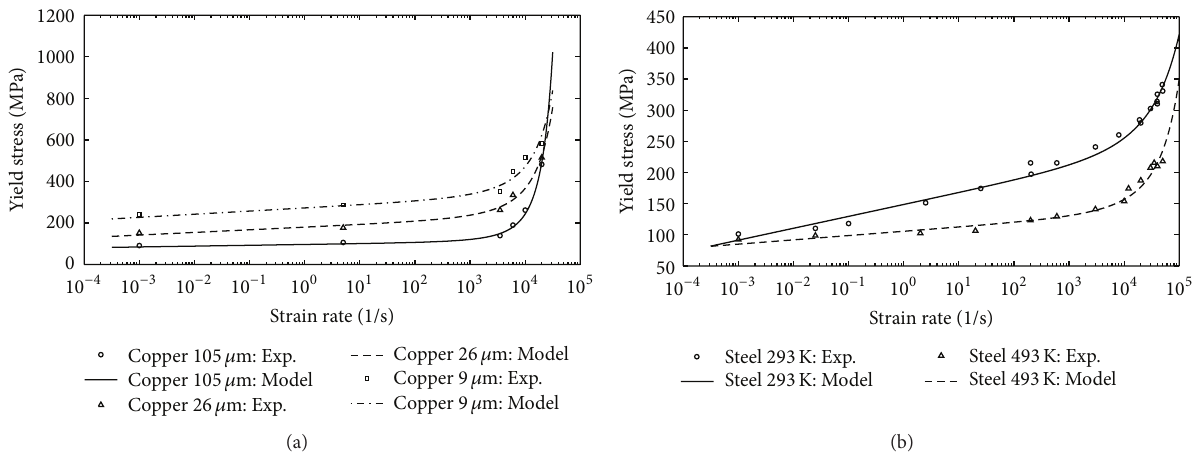
Figure 6: Yield stress fitting by the modified-Eyring model: (a) copper and (b) steel.